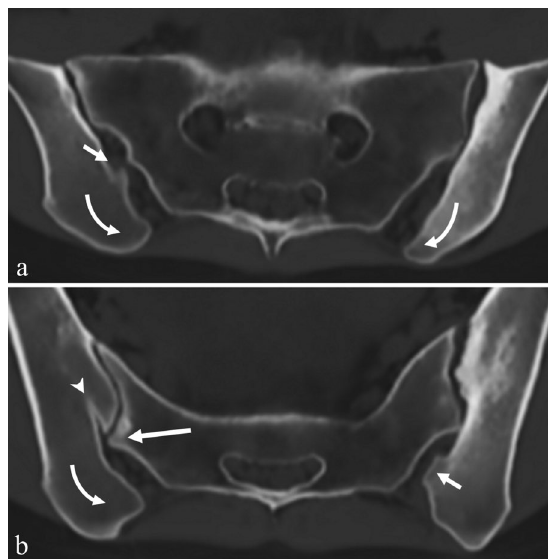
Fig. 4 Multiple sacroiliac joint (SIJ) variants coexisting in one patient. Semi-axial ( a ) and axial ( b ) synthetic CT images of multiple coexisting variants in a 27-year-old woman. An accessory SIJ is visible posterior to the cartilaginous part of the SIJ on both sides (short arrow), as well as crescent iliac bony plate (curved arrow). Additionally, dysmorphic SIJ (long arrow) accompanied by degenerative subchondral cyst and bipartite iliac bony plate (arrowhead) are present on the right side. Also note erosions and marked sclerosis on the left side